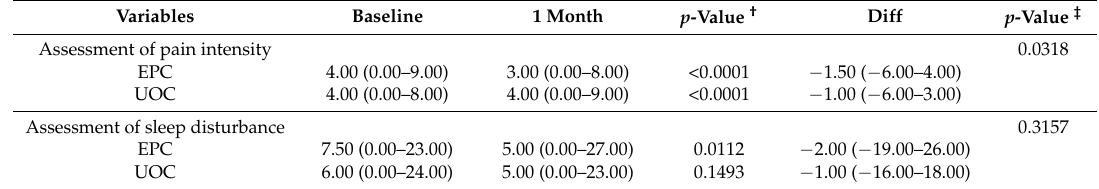
Table 5. Satisfaction with pain management, patient’s and investigator’s global assessment, and clinical global impression–improvement scale (CGI-I), for all patients 4 weeks after enrollment. Variables EPC UOC p -Value Satisfaction with pain